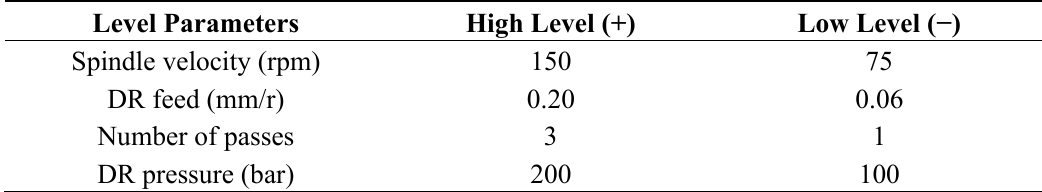
Table 1. Process parameters of DR-treated